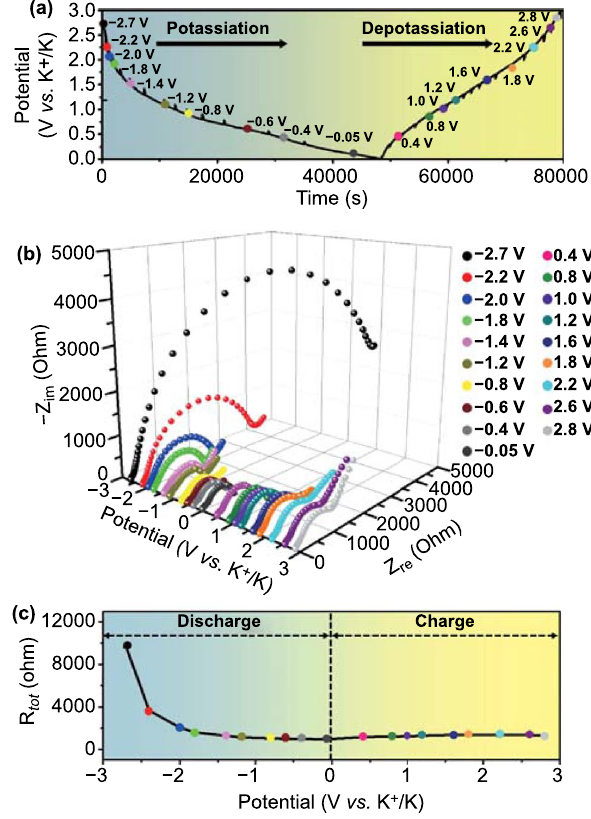
Fig. 6 In-situ EIS of FeSe x @C/MB: a Potential vs. times curve, b in- situ Nyquist plots, and c R tot values obtained at pre‑selected potentials during the first cycles at 0.05 A g